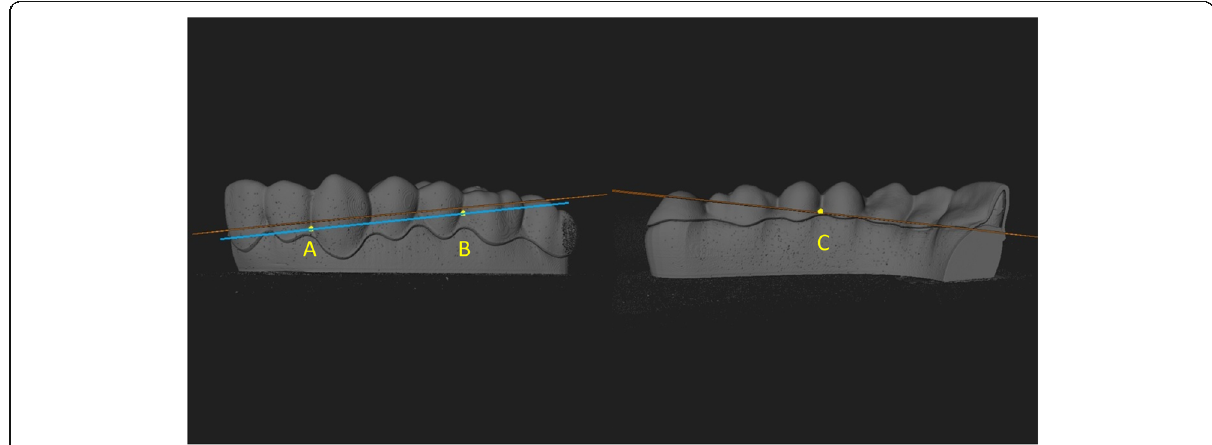
Fig. 2 Slice passing through the interdental labial papilla between lateral incisor and canine (point A), labial papilla between first molar and second premolar (point B), and palatal papilla between premolars (point